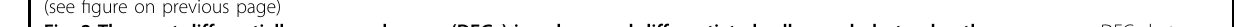
Fig. 2 The most differentially expressed genes (DEGs) in sphere and differentiated cells are cholesterol pathway genes. a DEGs between TS13-20 spheres (D0) and their differentiated counterparts (D7) were analyzed by RNA sequencing. Genes with expression changes more than four- fold are shown. DEGs are listed in Supplementary Table S2. b The cholesterol biosynthesis-related pathway was the dominant pathway altered in sphere (D0) cells according to functional enrichment analysis using FunRich (http://www.funrich.org). The top fi ve pathways are presented. c Down- and upregulated DEGs were subjected to gene network analysis using Cytoscape (http://www.cytoscape.org). Gene networks with P values < 0.005 are shown. d The change in the mRNA expression of various metabolic pathway genes between D0 and D7 cells was analyzed. Cholesterol-related genes were the only metabolic genes that varied between the two samples. The marker size is proportional to the log2-fold change (D0/D7). e Heatmap showing a clear distinction between the cholesterol pathway-related gene expression levels in the two samples. f Changes in the expression of cholesterol pathway genes were validated by RT-PCR and real-time quantitative PCR. The data are presented as the means of three independent experiments. *** P < 0.001 relative to